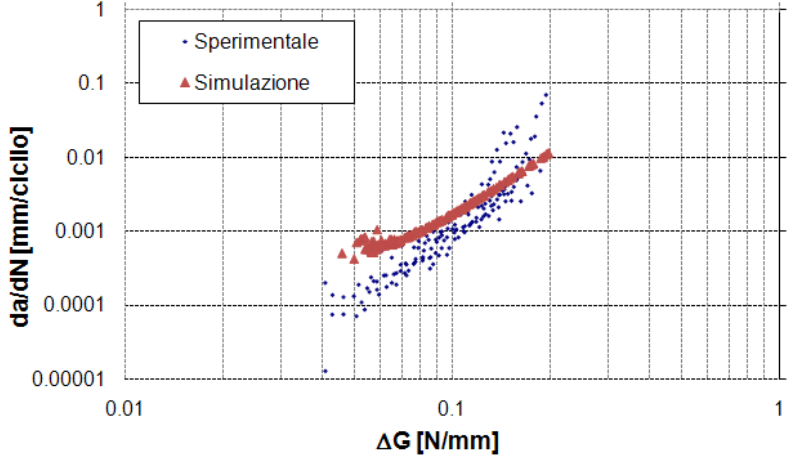
Figura 7: Confronto tra risultati sperimentali e previsione del modello ottenuto con Eq.